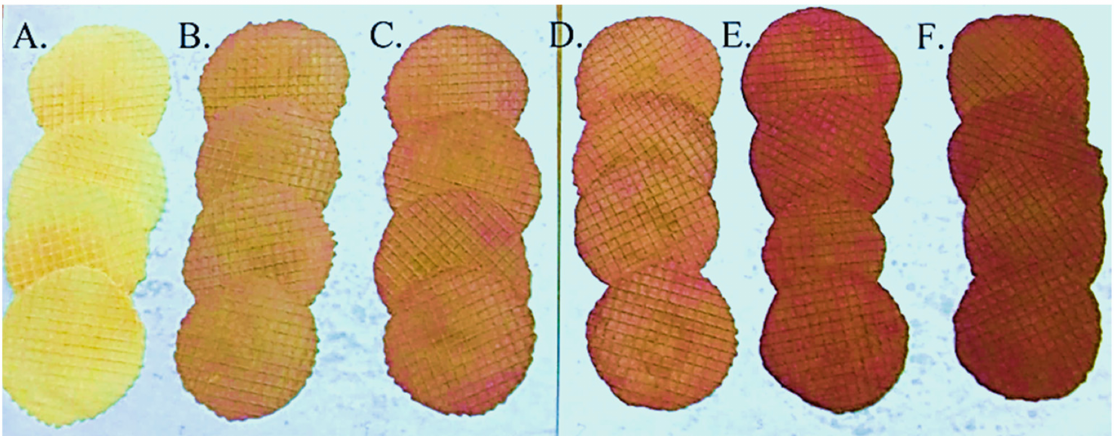
Figure 1. Prepared wafers: ( A ) control, ( B ) RP-10—wafers with 10% raspberry pomace, ( C ) RP-20—wafers with 20% raspberry pomace, ( D ) RP-30—wafers with 30% raspberry pomace, ( E ) RP-50—wafers with 50% raspberry pomace, ( F ) RP-75—wafers with 75% raspberry